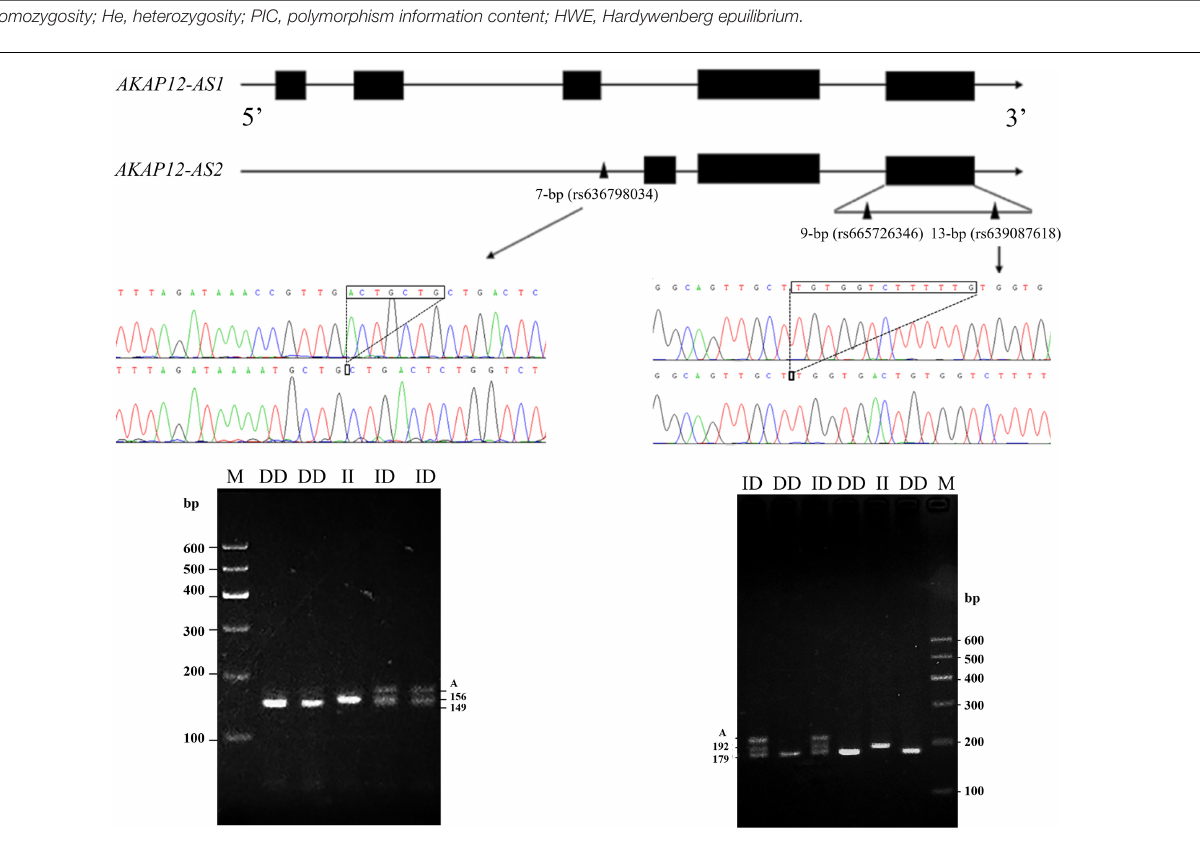
FIGURE 1 | The electrophoresis diagrams and sequencing diagrams of goat AKAP12 gene indel loci. Black boxes: exon; Black triangle: mutation site; “A” means